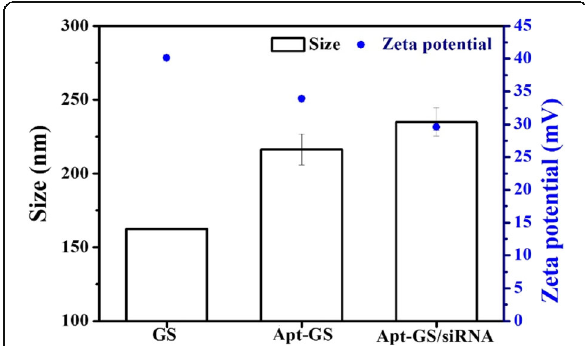
Fig. 2 Hydrodynamic size and zeta potentials of GS, Apt-GS, and Apt-GS/siRNA